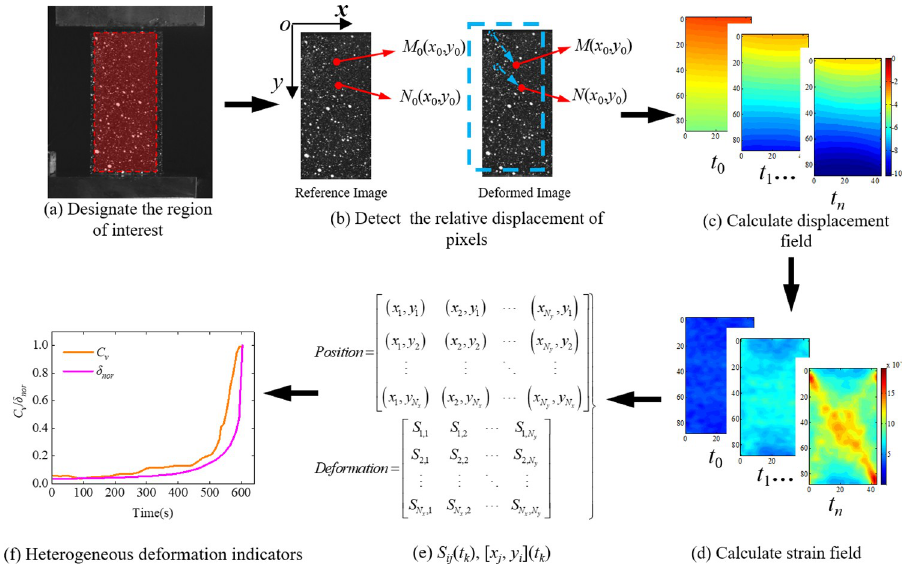
Fig 4. Workflow of 2D-DIC to obtain heterogeneous deformation indicators.